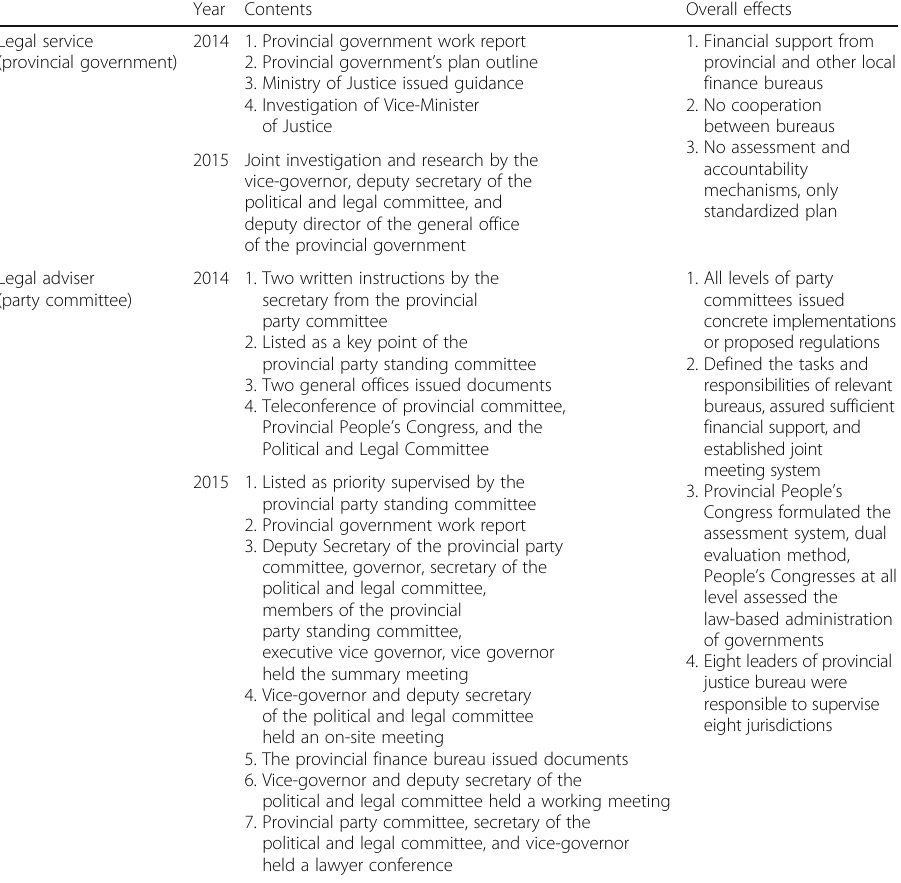
Table 1 Comparison of the effects of competition for